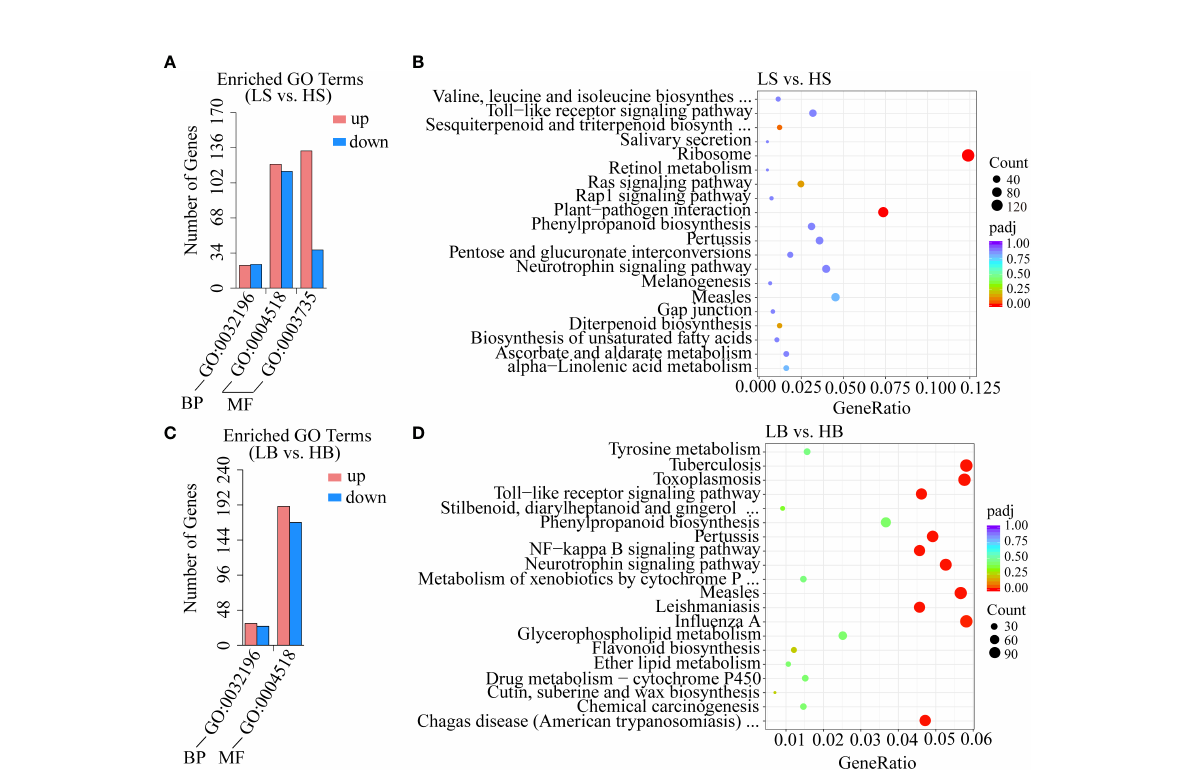
FIGURE 6 GO and KEGG enrichment analyses of DEGs. (A, B) are the enrichment analyses of GO and KEGG (the most signi fi cant 20 pathways enriched) of H. ammodendron DEGs. (C, D) are the enrichment analyses of GO and KEGG (the 20 pathways with the most signi fi cant enrichment) of H. persicum